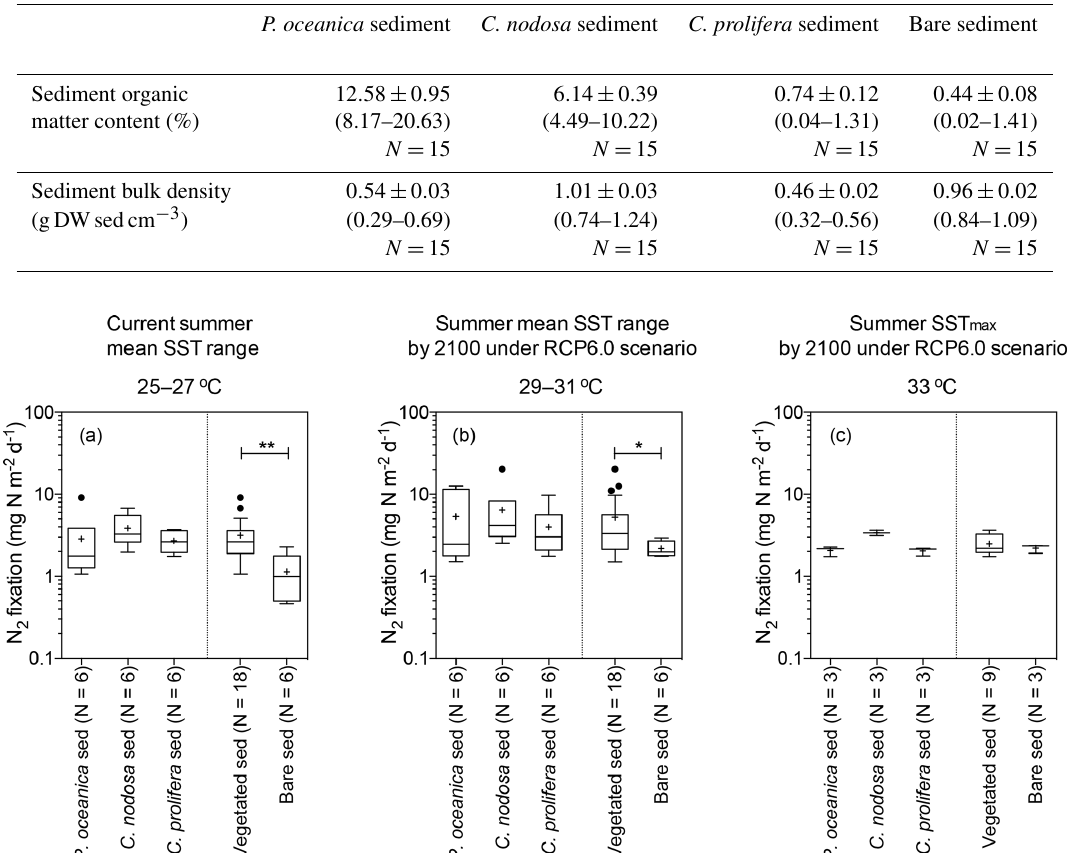
Table 1. Organic matter content and bulk density in sediments colonized by different macrophyte species and bare sediment in Pollença Bay (Mallorca) in June 2017. Mean values ( ± SEM), ranges (minimum–maximum values), and the sample size ( N ) are shown.